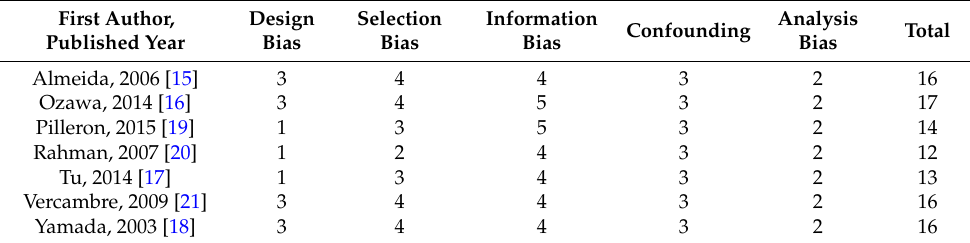
Table A2. Quality assessment of each eligible article (maximum score =